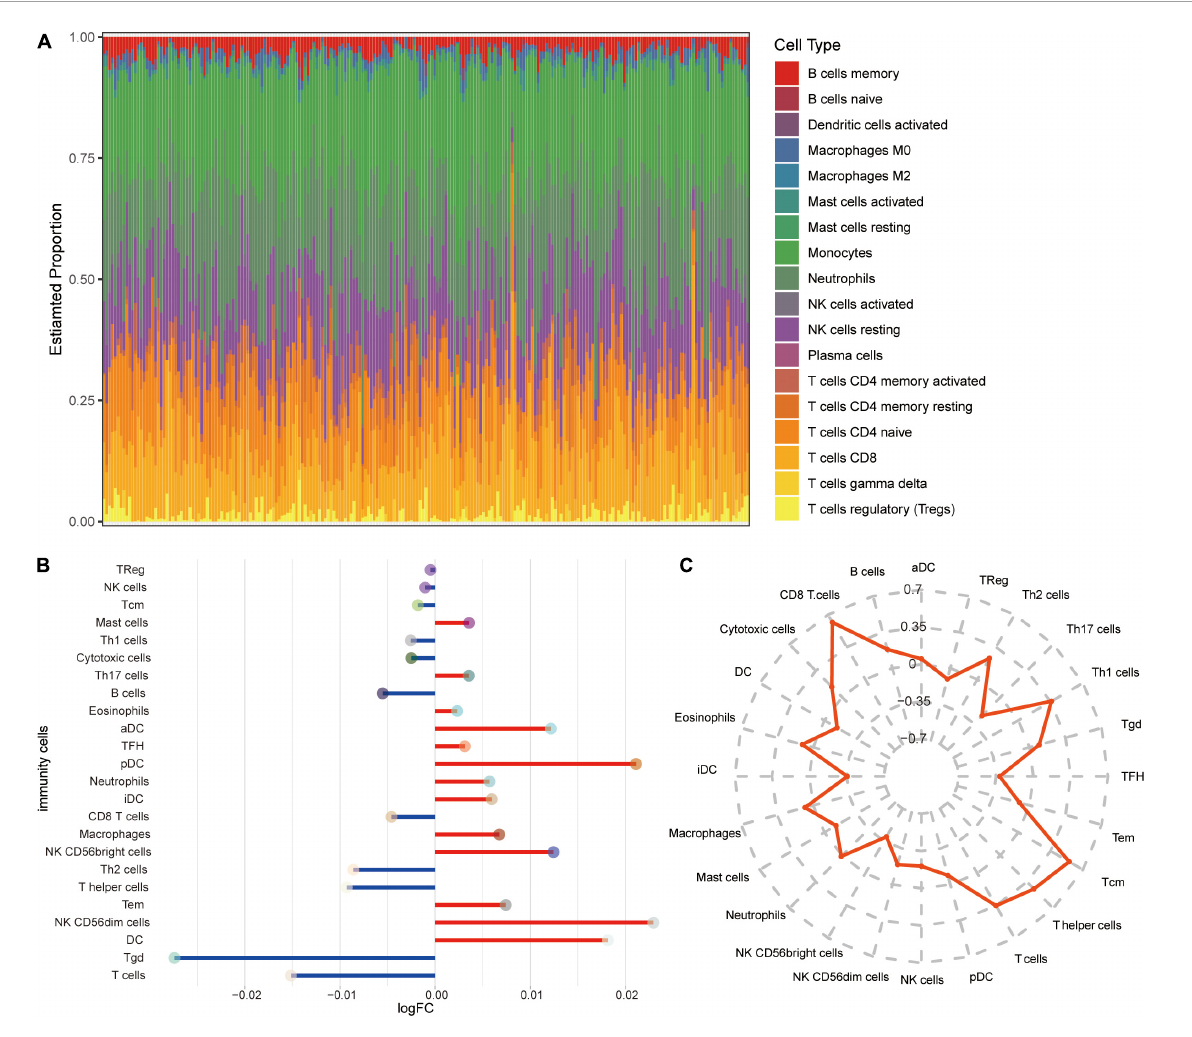
FIGURE6 Alterations in immune cells in AD. (A) Estimated proportions of 24 immune cell types in AD samples of GSE63060 dataset. X-axis means AD samples. (B) Differential levels of immune cells between AD and MCI. Red indicates up-regulation, and green indicates down-regulation. (C) Correlations between immune cells and